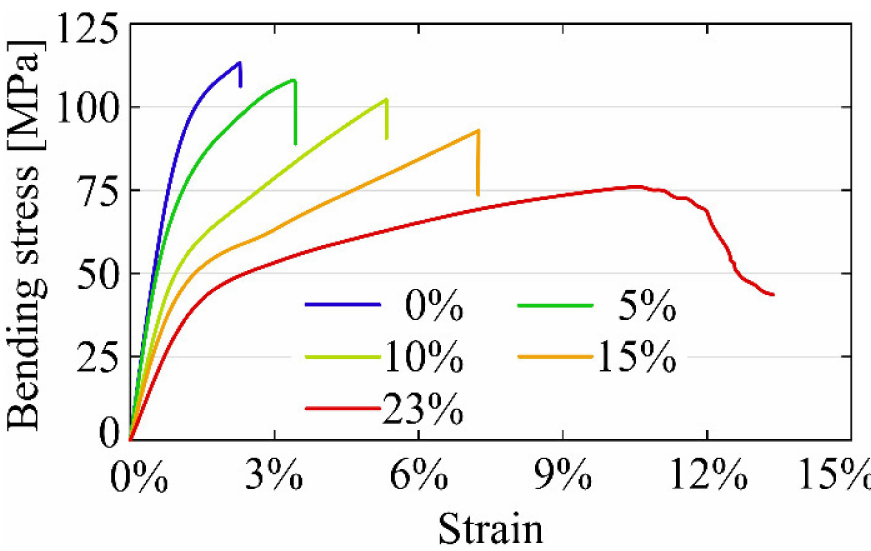
Figure 9. Stress–strain graphs of the 3-point bending test data, which represent the investigated com- pression ratios well. Numerical test results of Kuzsella [74] were used to plot the graph, reproduced from [59] with permission from B á der,